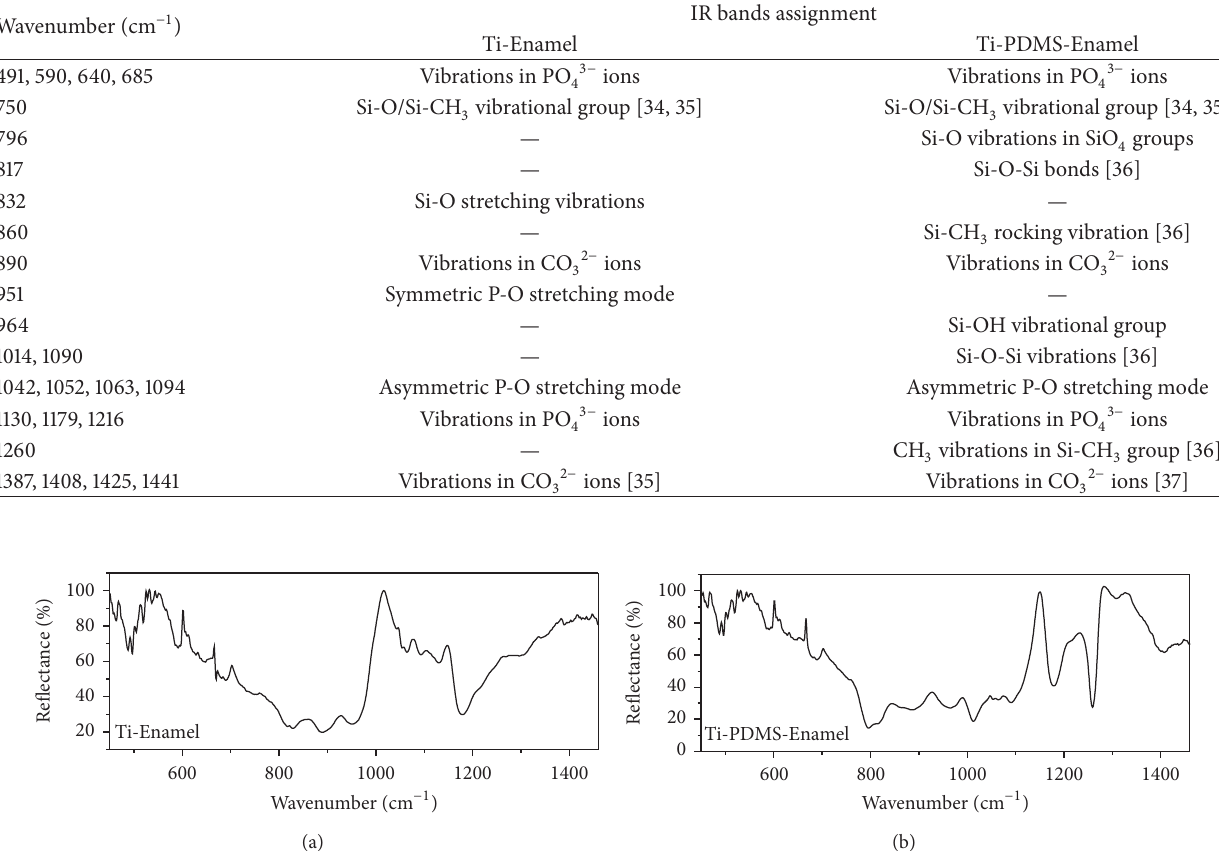
Table 1: The main functional IR groups present in the structure of Ti-Enamel and Ti-PDMS-Enamel layers. Wavenumber (cm −1 )